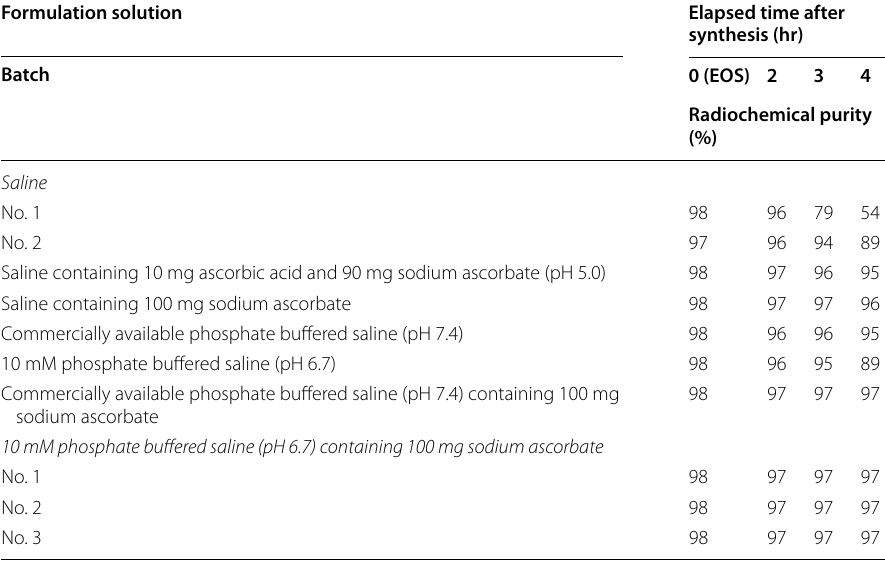
EOS, end of synthesis